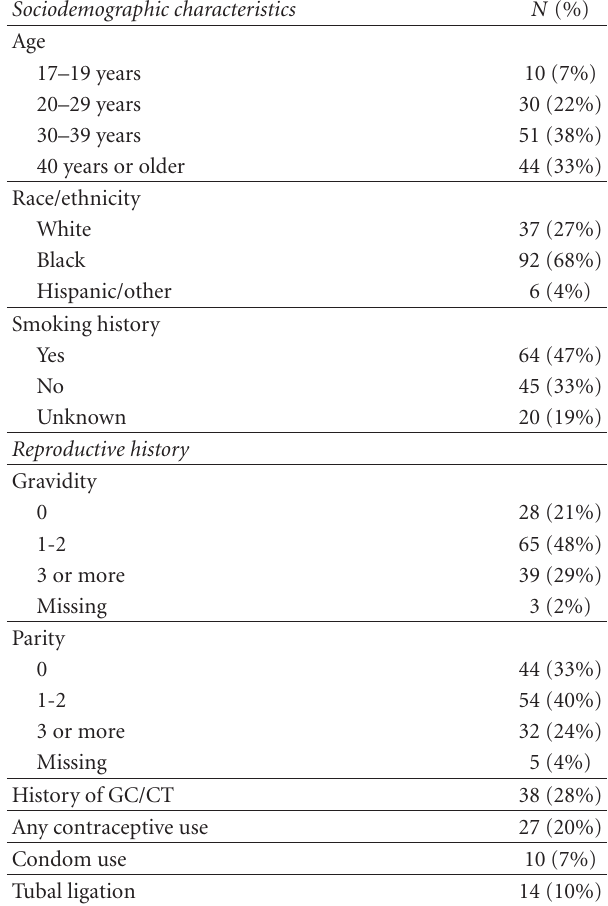
Table 2: Clinical characteristics by presence of TOA. Clinical